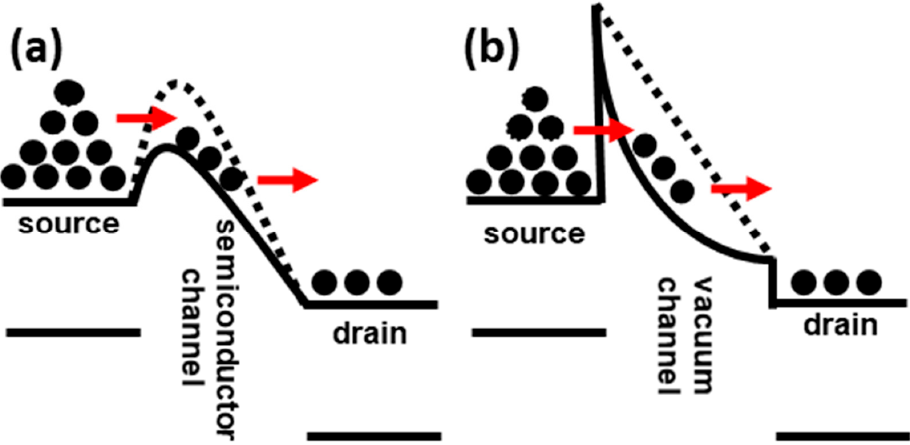
Figure 3. Energy band diagrams of a ( a ) metal-oxide-semiconductor field-effect transistors (MOSFET) and ( b ) vacuum channel transistor. The carrier transport mechanism of a MOSFET is thermionic emission, while that of a vacuum channel transistor is Fowler–Nordheim tunneling, respectively.